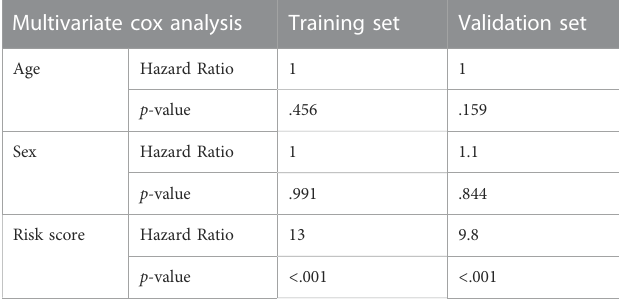
TABLE 1 Multivariate Cox analysis of the training and validation sets. Multivariate cox analysis Training